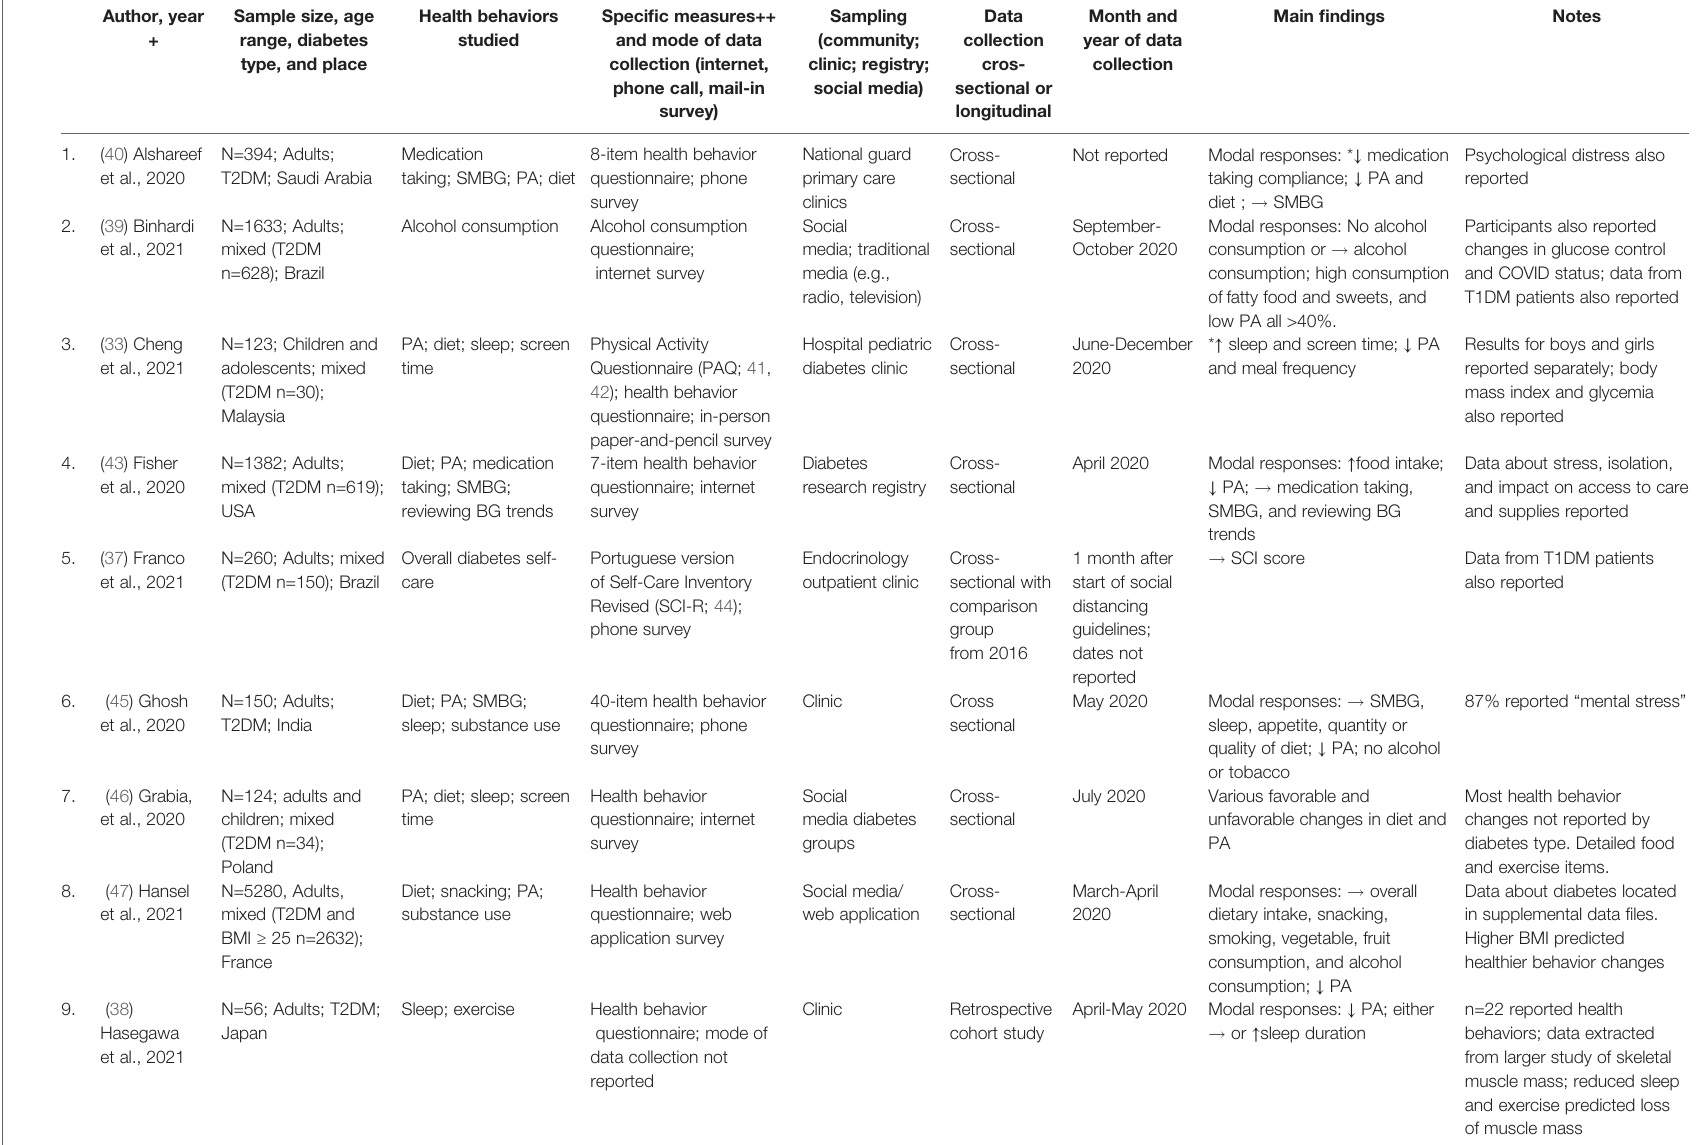
TABLE 2 | Change in health behaviors from pre-COVID period to COVID among people with type 2